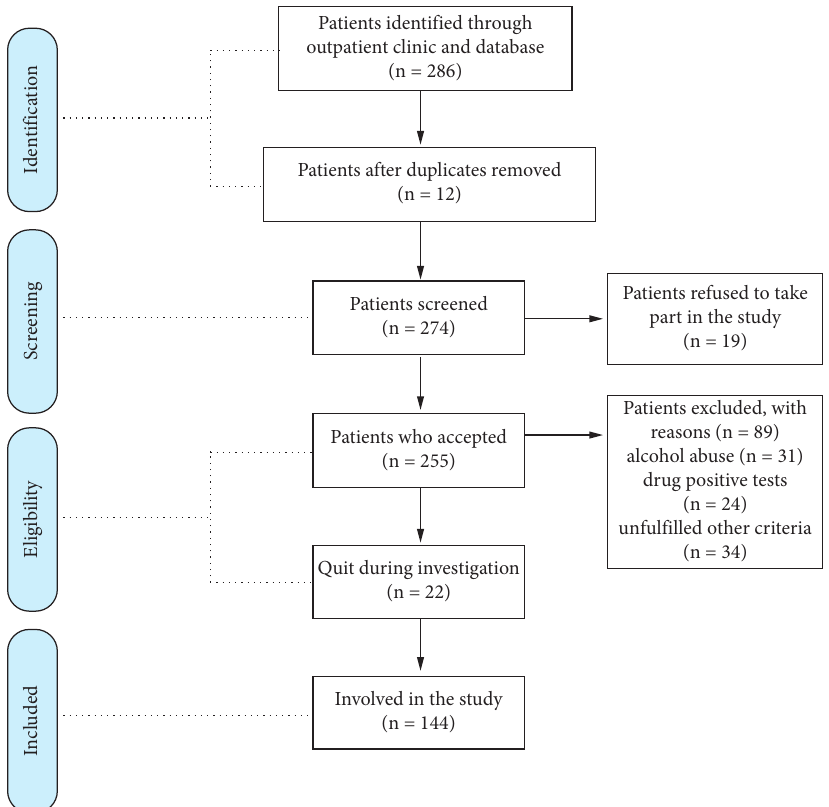
Figure 1: Patient selection